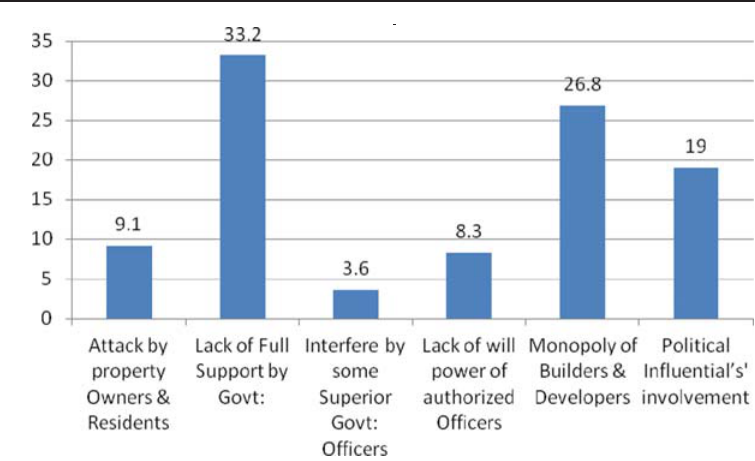
FIG. 7. RESPONSIBLE MAKING PROBLEMS TO AVOID SMOOTH ENFORCEMENT OF LAND USE & DEVELOPMENT